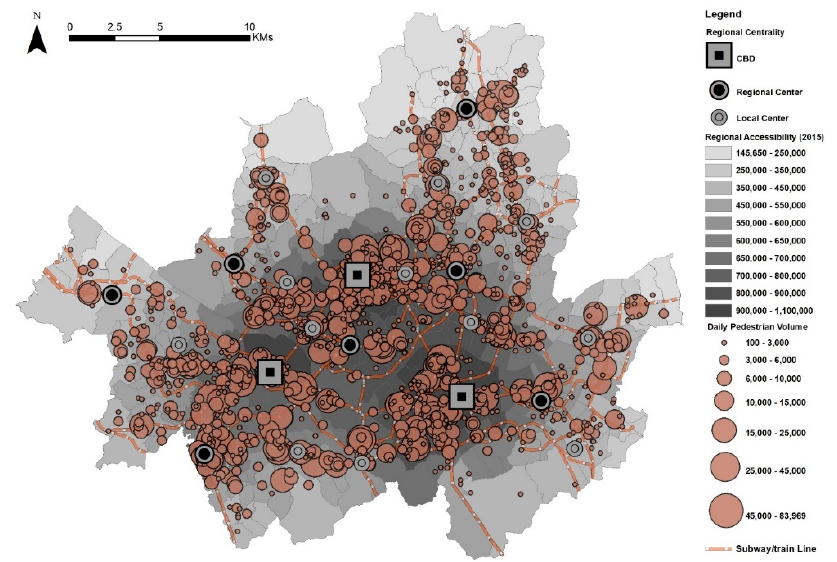
Figure 3. Central places in 2014 [54], regional job accessibility in 2015 (authors’ calculation), and 2015 PVS spots and their results (2015 PVS data). 2015 PVS spots and their results (2015 PVS